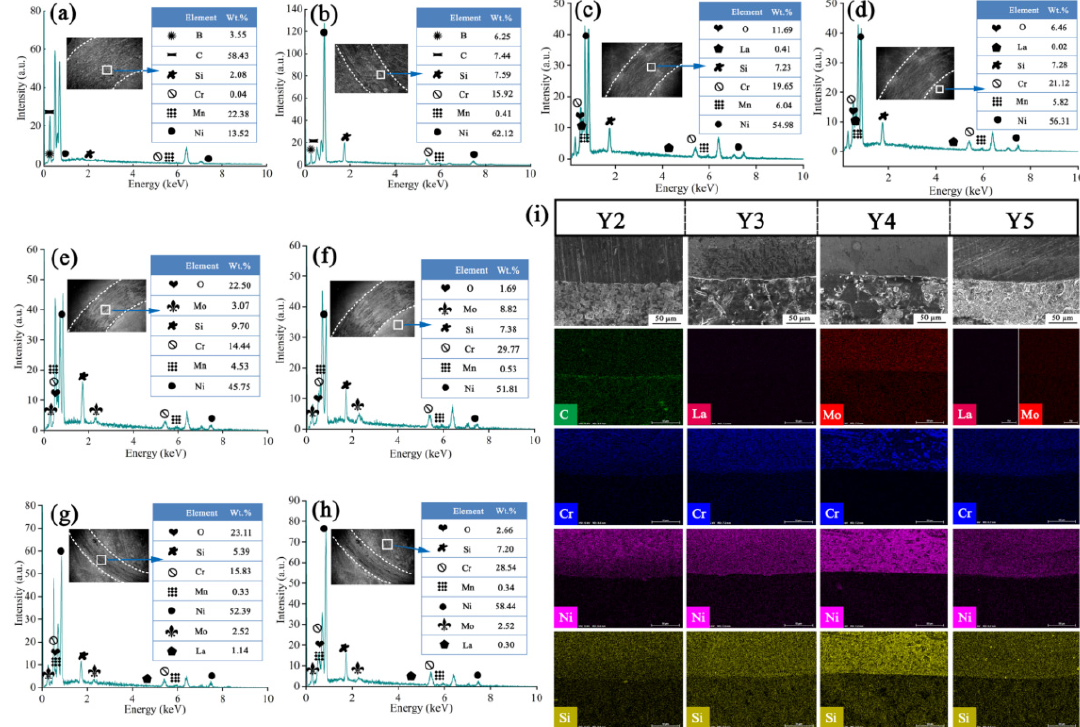
Figure 5. Element Analysis of Wear Surface of Sample: ( a ) Y1, ( b ) Y2, ( c , d ) Y3, ( e , f ) Y4, ( g , h ) Y5. ( i ) EDS mapping of Y1~Y5.